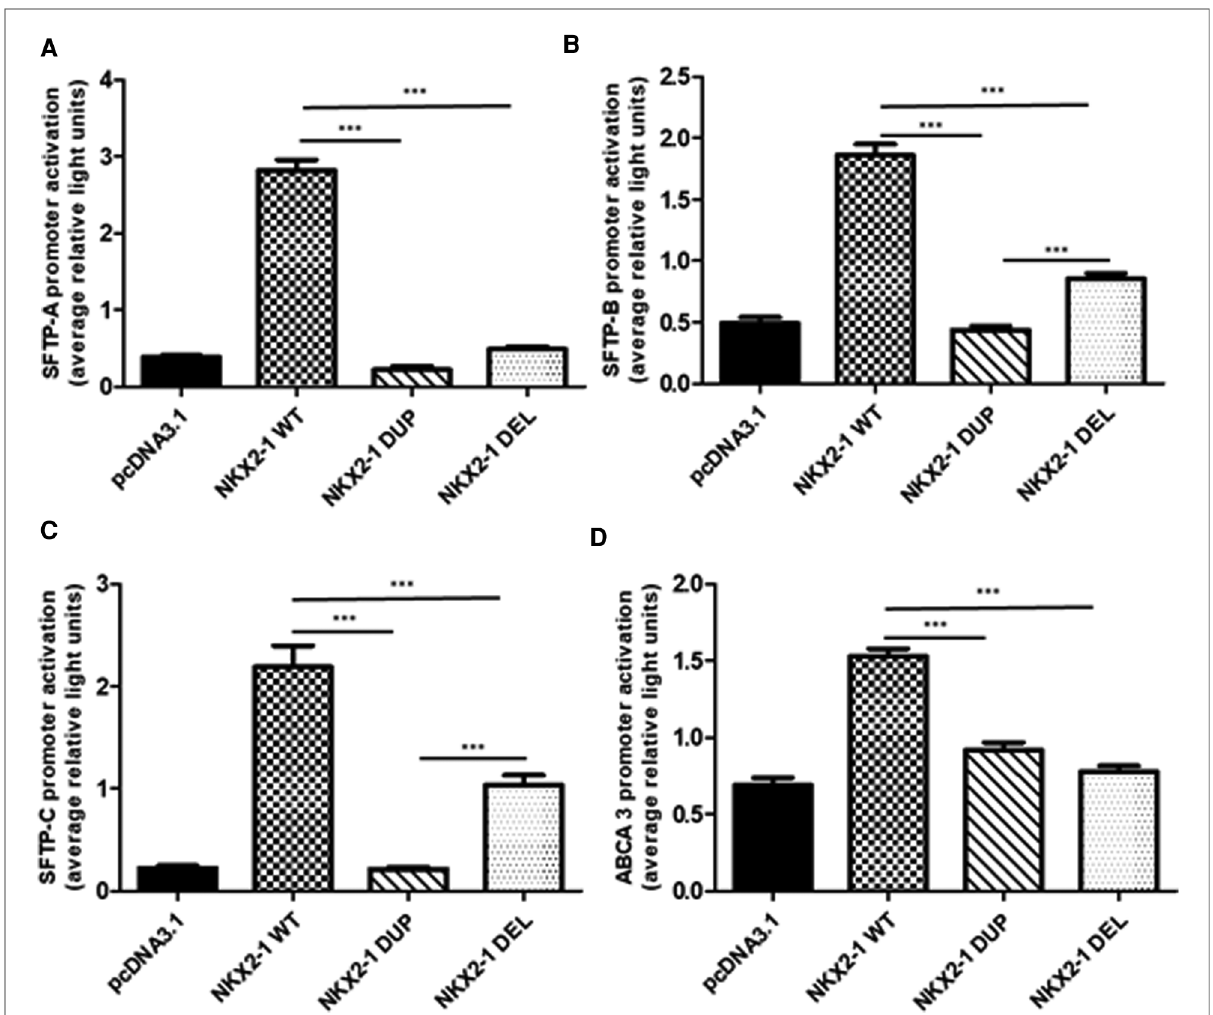
FIGURE 3 Functional activity of wild-type vs. mutant NKX2-1 on promoters of lung-speci fi c genes ( SFTPC , SFTPB , ABCA3 and SFTPA ). Transactivation of SFTPA ( A ), SFTPB ( B ), SFTPC ( C ), and ABCA3 ( D ) by wild-type NKX2-1, NKX2-1 DUP or NKX2-1 DEL . Promoter constructs were co-transfected in A549 cells ( A – D ) with the empty pcDNA3.1 vector or expression vector for the wild-type or mutated NKX2-1 cDNAs. Data are mean±SEM of fi ve independent experiments performed in duplicate. * p <0.05, ** p <0.01, *** p